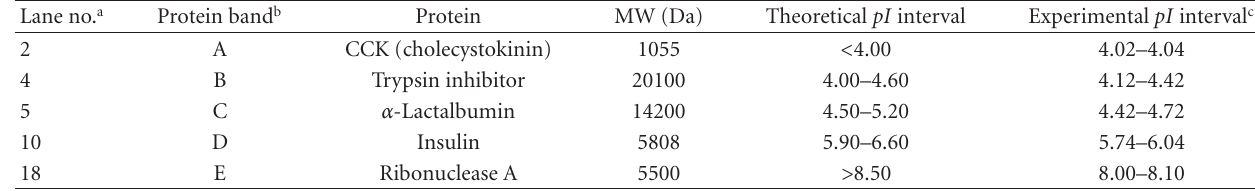
Table 1: The summary of experimental and theoretical pI intervals of five proteins included in protein test mixture purchased from Beckman